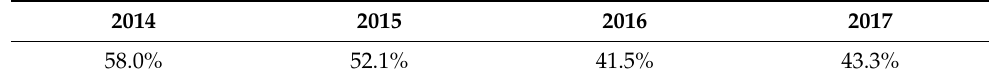
Table 3. LE / Rn ratio using cumulative values over each growing